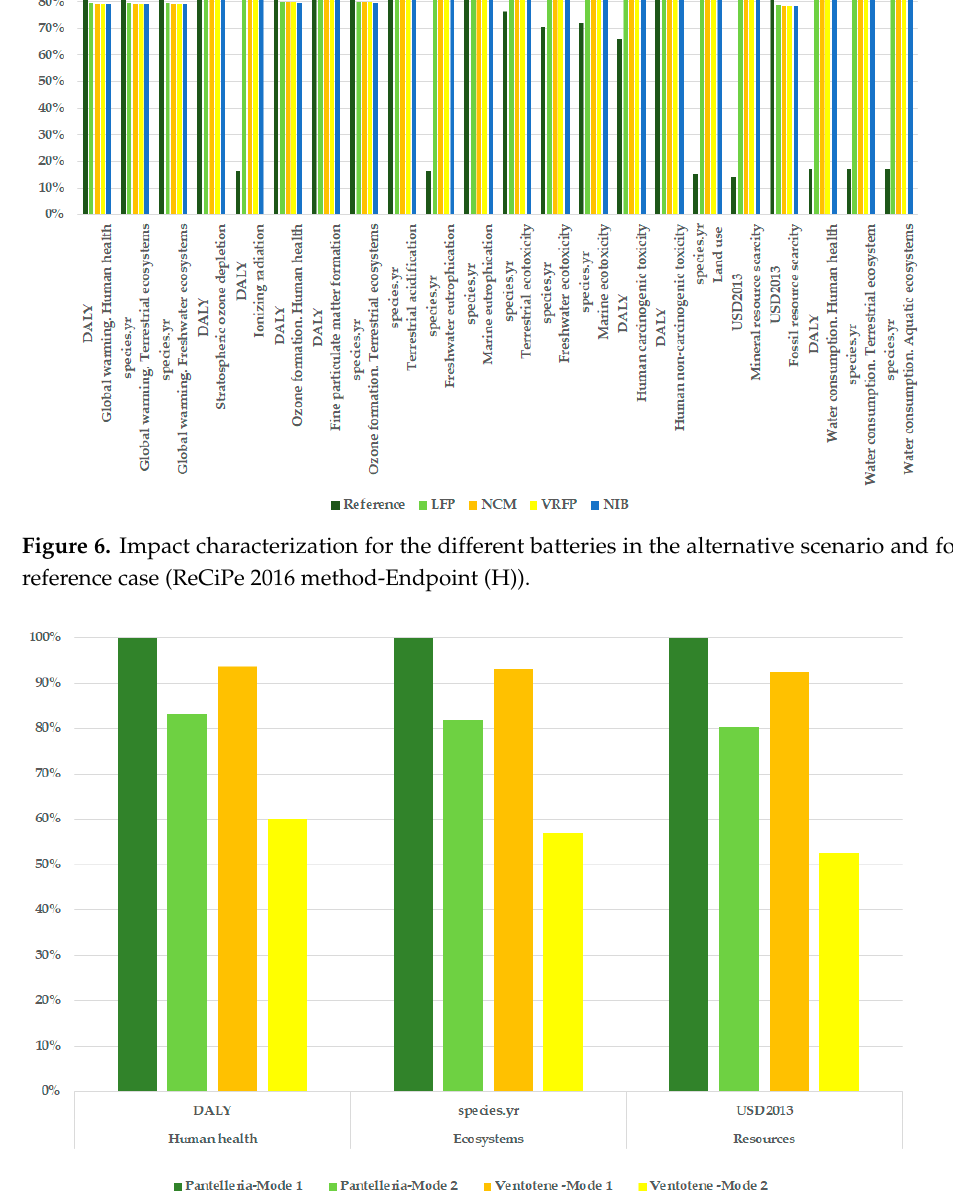
Figure 7. Damage assessment for the energy systems with NIBs in Pantelleria and Ventotene (ReCiPe 2016 Method-Endpoint (H)).